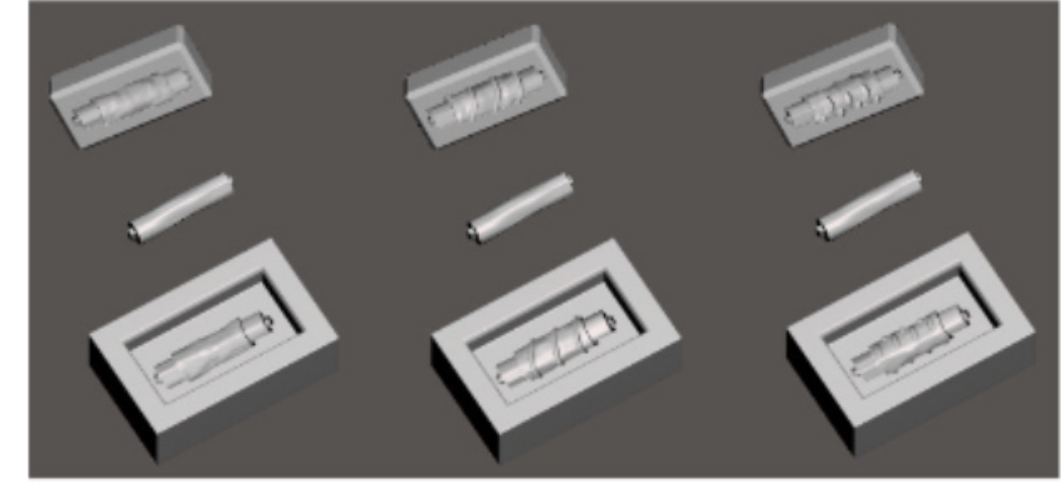
Figure 6. Printing molds and middle pieces (Reprinted from an open-access source) [138].